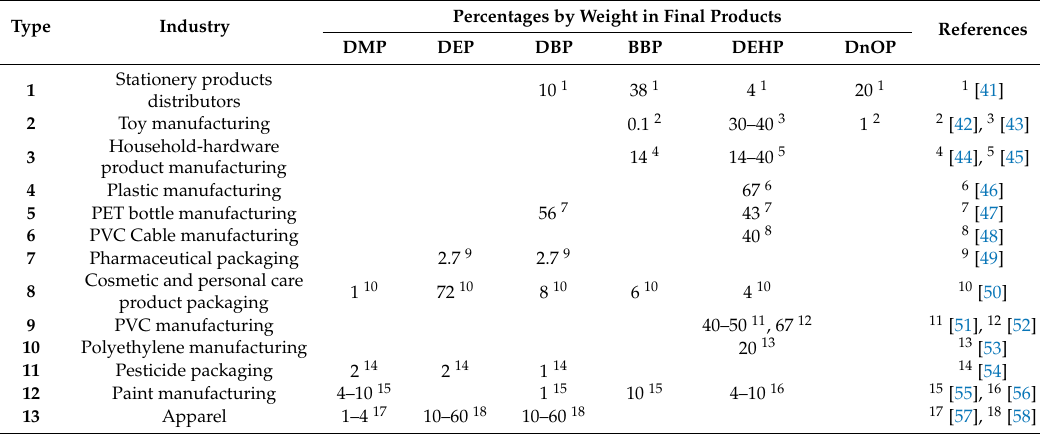
Table 7. Typical percentages of different PAEs in industrial